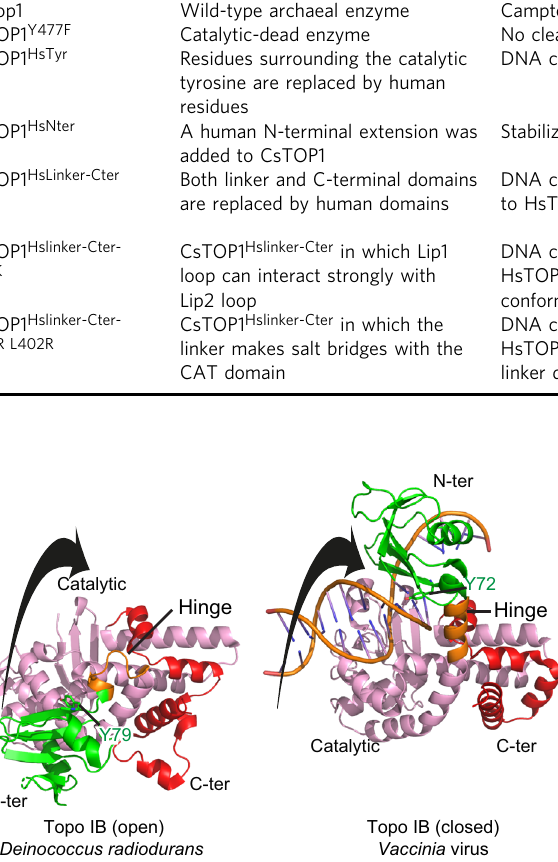
Fig. 7 Comparison of short Topo IB domains in their open and closed conformations. Superimposition of Topo IB from Deinococcus radiodurans (PDB 2F4Q) and from Vaccinia (PDB 2H7G). Coloring is the same as in Fig. 1. The black arrow represents the rotation of the CAP domain from the open to the closed